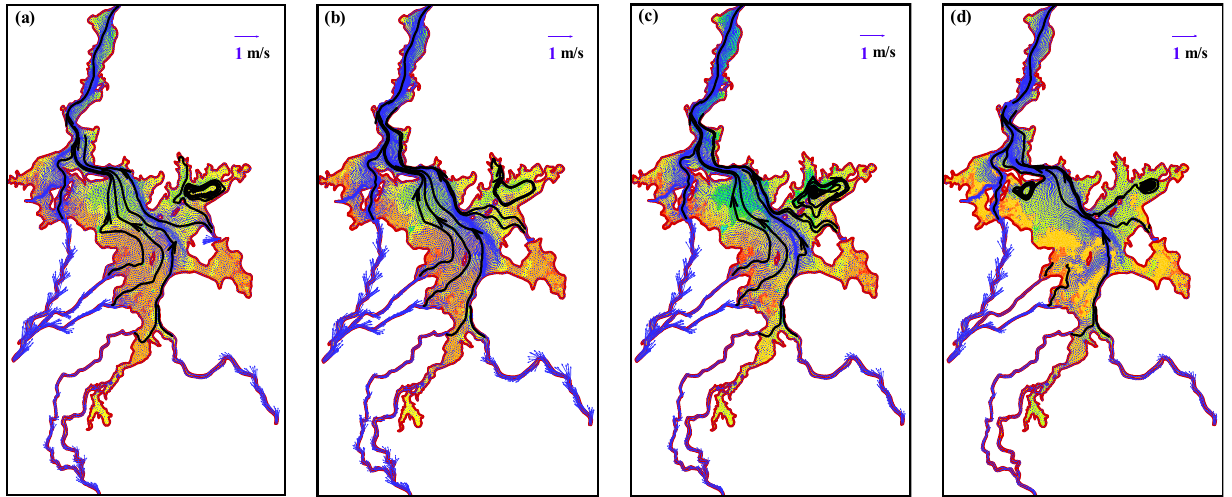
Figure 3. Map of the velocity fields (in blue arrows) overlapped the lake bathymetry at selected time slices: ( a ) 15 July; ( b ) 15 August; ( c ) 15 September; and ( d ) 30 September. The black lines with arrows represent the streamlines generated by the flow